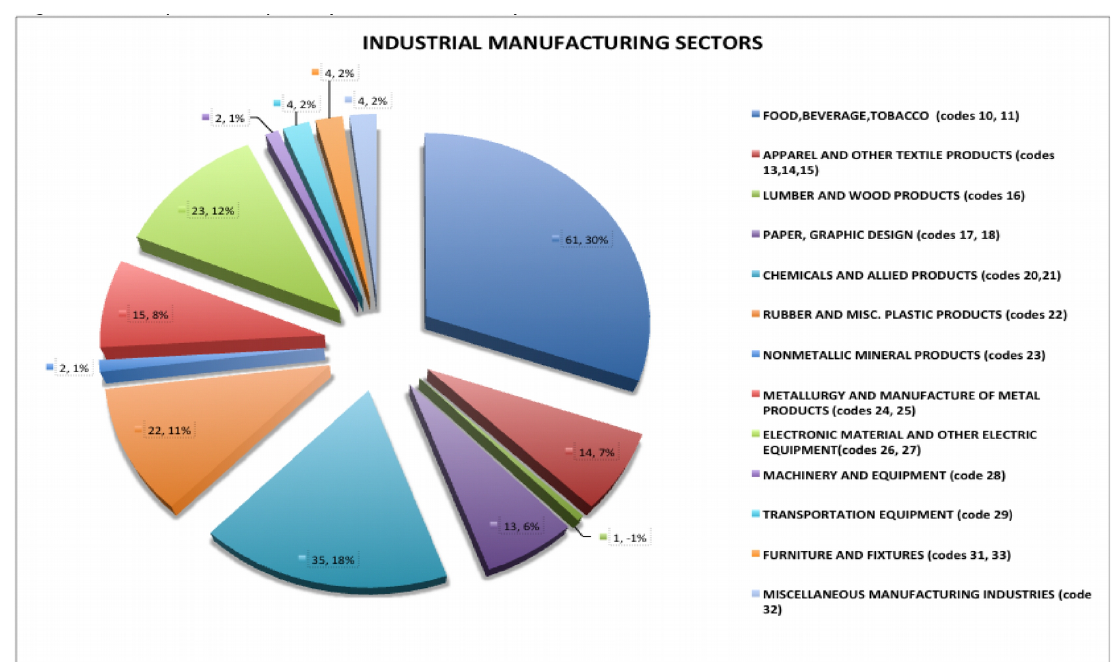
Figure 2. Sample description (industrial